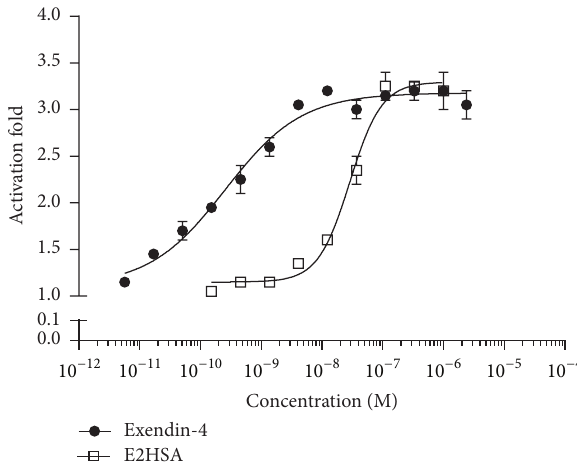
Figure 1: E2HSA exhibits GLP-1 receptor activating efficacy in NIT- 1 cells. NIT-1 cells transiently transfected with Peak12 RIP-CRE 6x Luciferase reporter gene plasmid were treated with indicated concentrations of E2HSA and exendin-4 for 24 hours. Luciferase expression in cell lysates was measured by chemiluminescence. Data obtained were used to calculate the activation fold at different concentrations. Values are expressed as means ± S.E.M and are representative of data from two independent experiments, each performed in